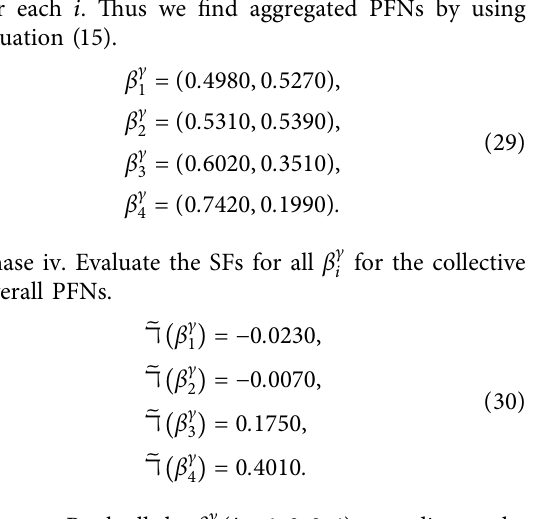
Phase v. Rank all the β c score values.